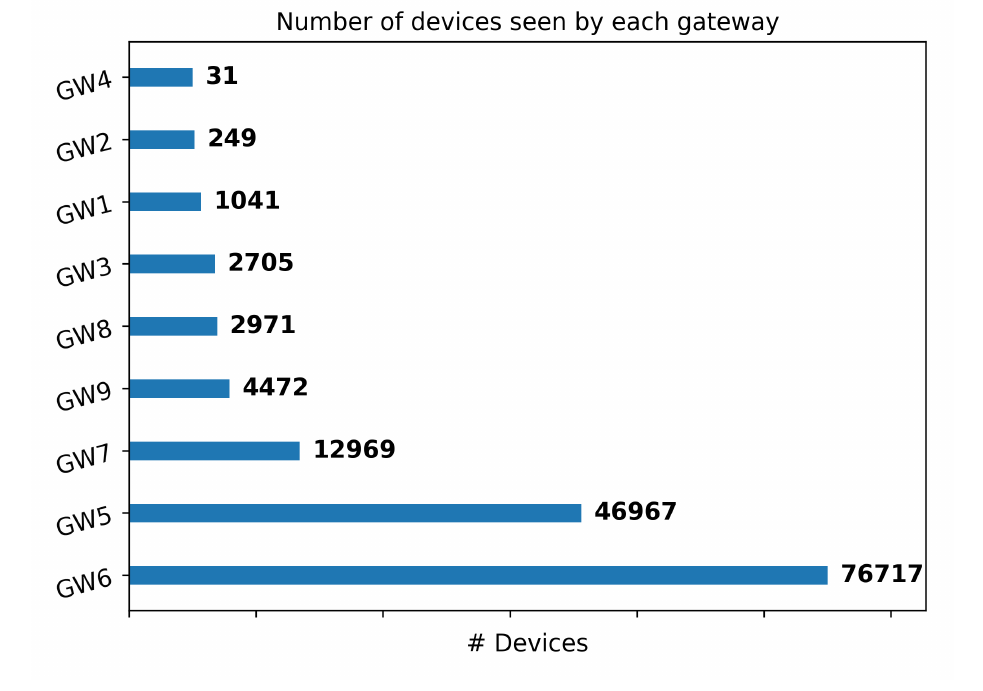
Figure 11. Histogram representing the number of devices managed by each gateway in the